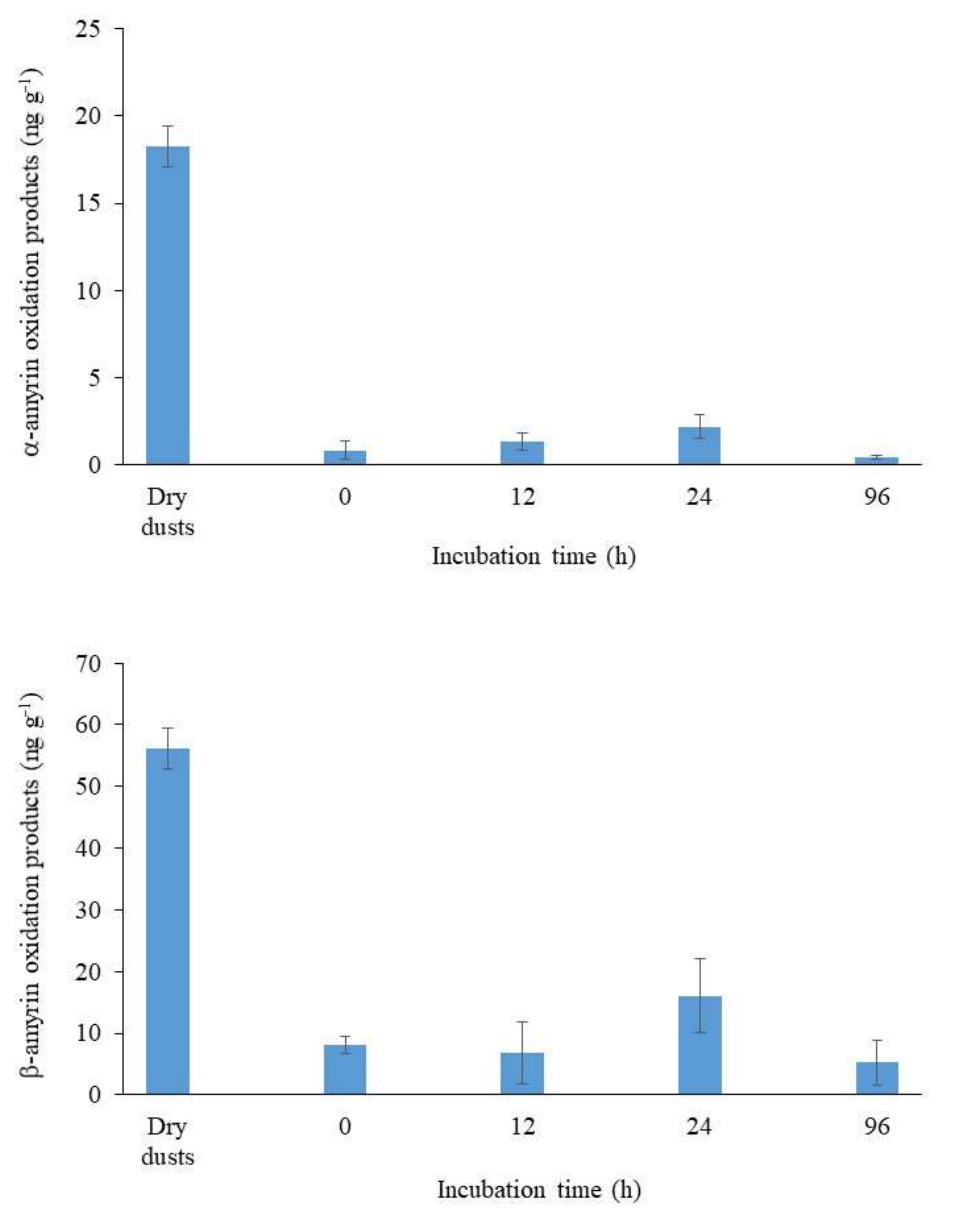
Figure 5. Time-course degradation of amyrin oxidation products in fresh water.